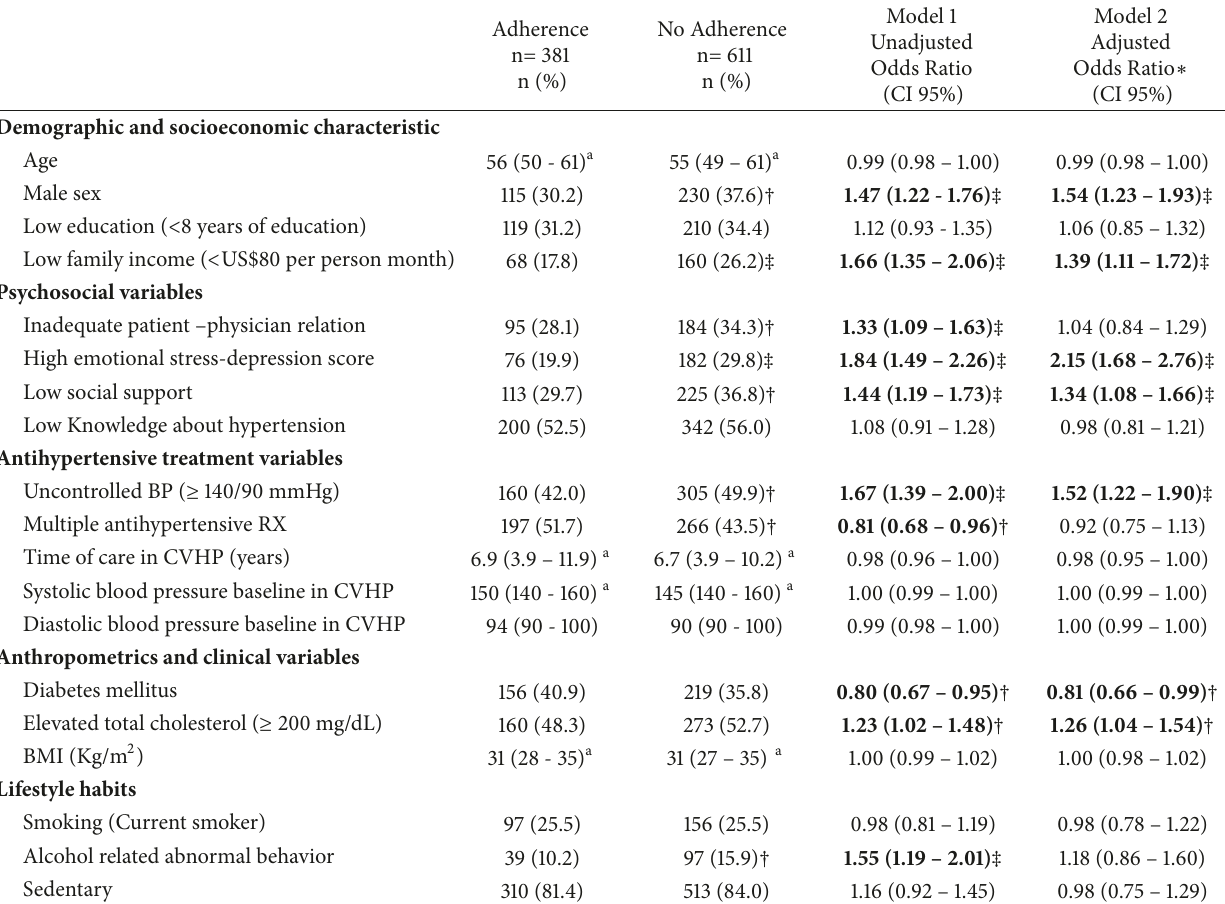
Table 3: Multivariable adjusted odds ratio for no adherence risk to antihypertensive in hypertensive patients followed in the Cardiovascular Health